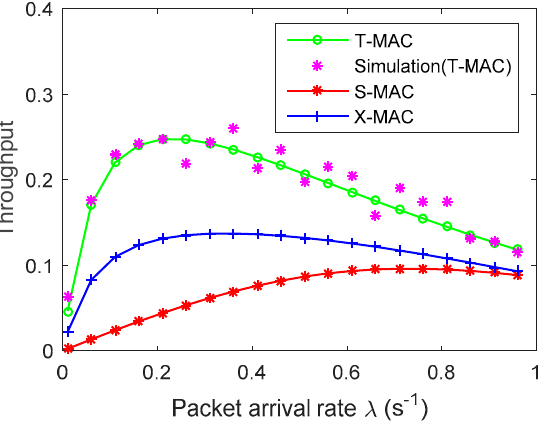
Figure 6. The throughput versus packet arrival rate ⋋ for the T-MAC, S-MAC and X-MAC protocols.